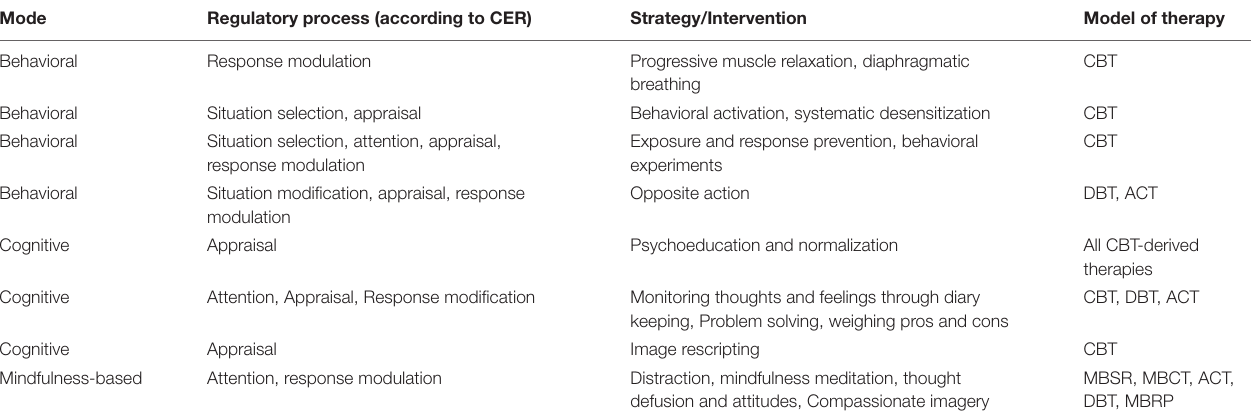
TABLE 2 | Standard Cognitive-Behavioral techniques for regulating